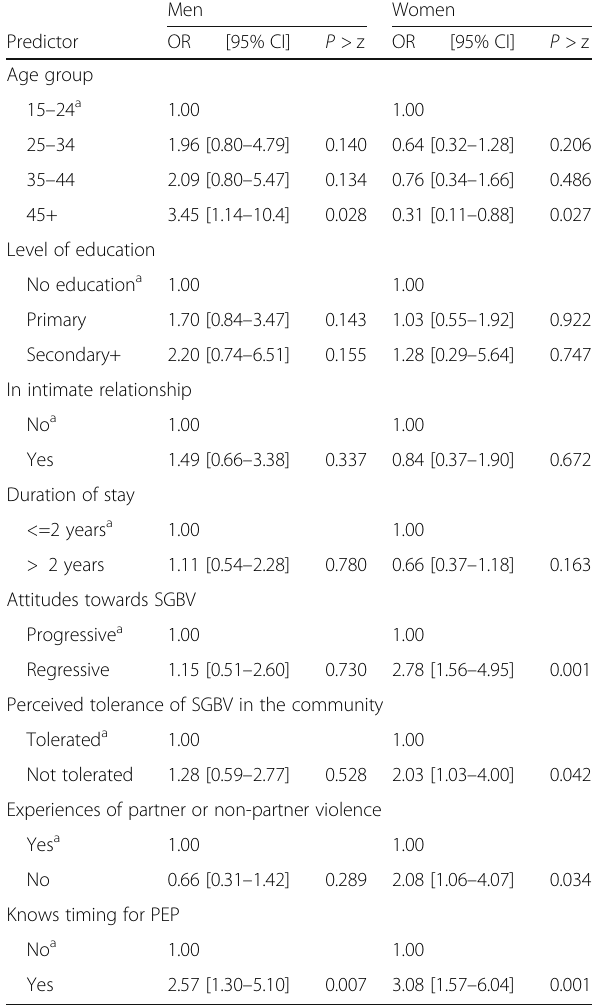
Table 4 Adjusted Odds ratios from a multivariate logistic regression model showing factors associated with favorable attitudes towards help-seeking for SGBV among men and